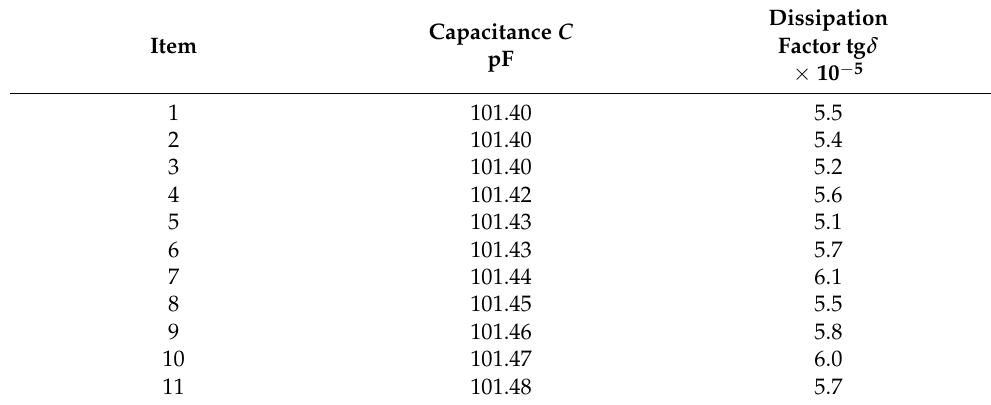
Table 1. Values of the capacitors used in the SCM. The uncertainty of the capacitance measurements was